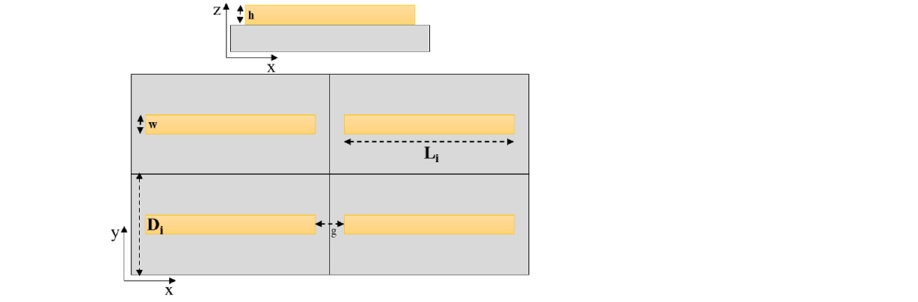
Figure 6. Schematic representation of the gold nanoantennas showing the geometric parameters used in the FDTD simulation.